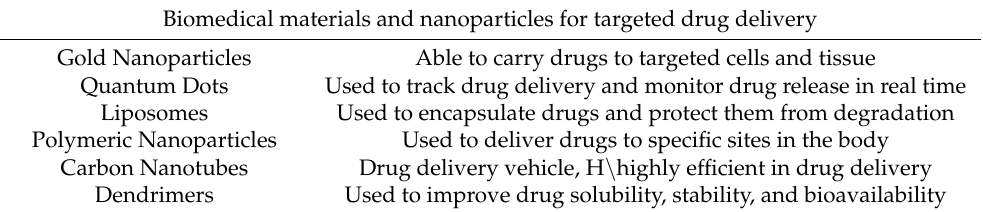
Table 3. Biomedical materials and targeted drug delivery using nanoparticles. Biomedical materials and nanoparticles for targeted drug delivery Gold Nanoparticles Able to carry drugs to targeted cells and tissue Quantum Dots Polymeric Nanoparticles Carbon